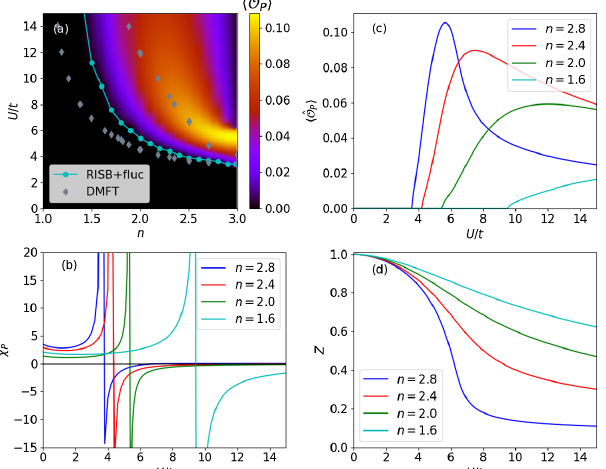
FIG. 5. (a) Density plot of the s -wave spin-triplet supercon- ˆ O ducting order parameter h as a function of electron filling n P i and temperature T at U ¼ 8 and J ¼ U= 4 . The cyan line is the phase boundary determined from the instability of the pair- ing susceptibility χ . (b) Uniform pairing susceptibility χ for P P n ¼ 2 . 8 , 2.4, 2.0. (c) Density plot of the spin-triplet super- ˆ O conducting order parameter h as a function of Coulomb P i interaction U and temperature T with n ¼ 2 . 7 and J ¼ U= 4 . The cyan line is the phase boundary determined from the instability of the pairing susceptibility χ . (d) Uniform pairing susceptibility χ P P for U ¼ 5 t; 16 t; 12 t